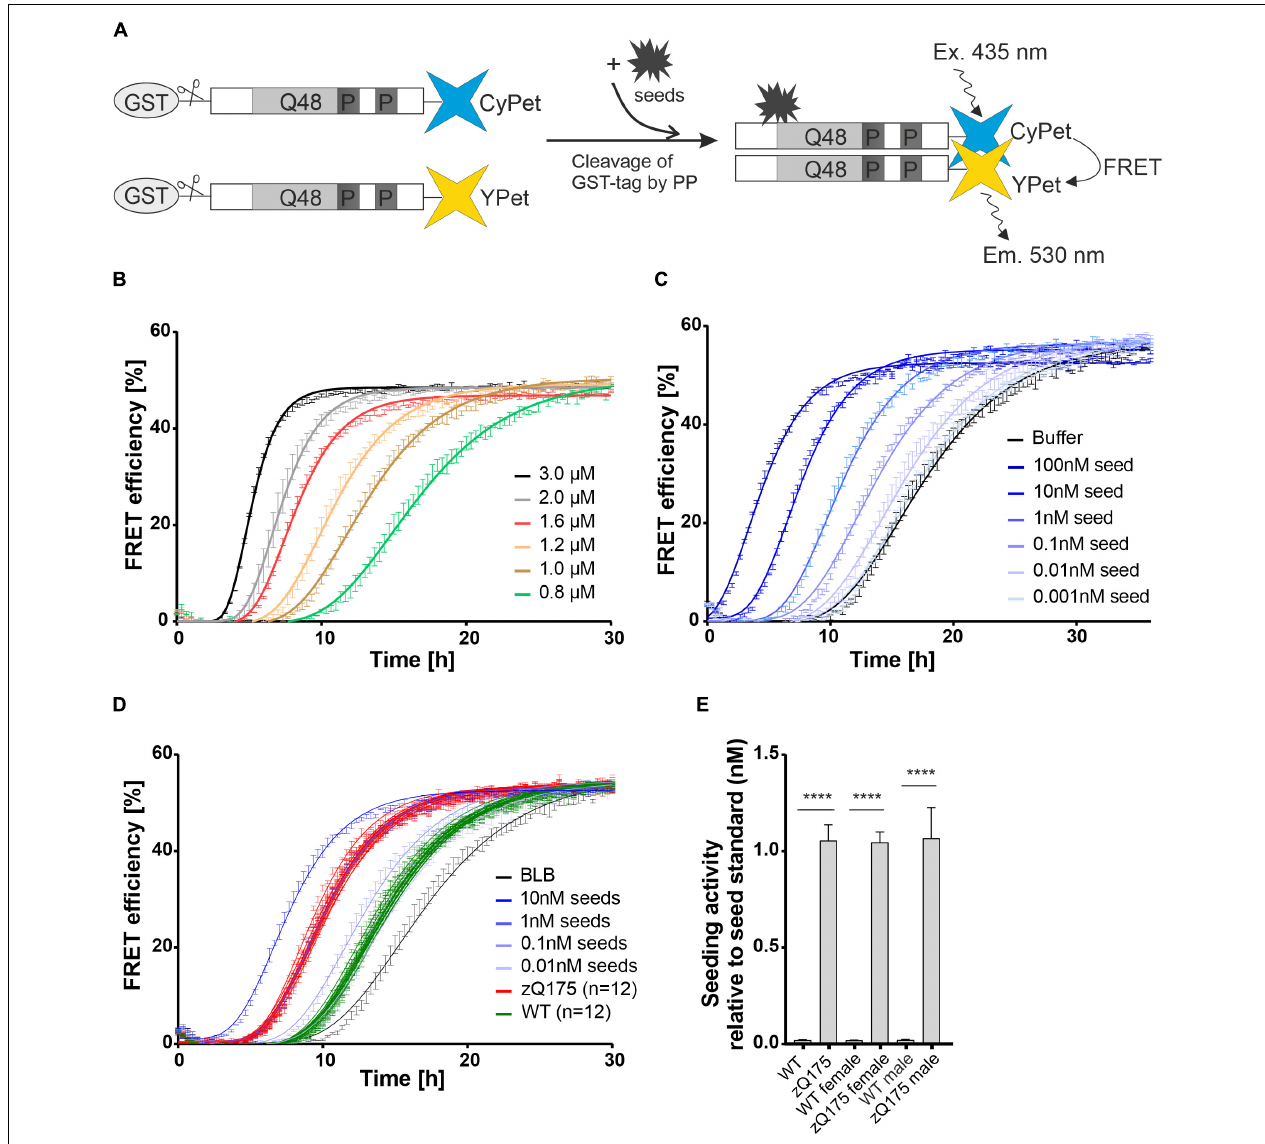
FIGURE 1 | Establishment of FRET-based mHTT aggregate seeding assay (FRASE) for testing biological samples. (A) Schematic representation of FRASE. PP, PreScission Protease. (B) Time- and concentration-dependent co-aggregation of Ex1Q48-CyPet and Ex1Q48-YPet sensor proteins (1:1 mixture, 0.8–3.0 µ M) monitored by repeated FRET measurements. FRET efficiency is displayed as mean ± SEM of technical triplicates. (C) Effect of different concentrations of preformed Ex1Q48 seeds on Ex1Q48-CyPet and Ex1Q48-YPet (1:1 mixture, 1.2 µ M) co-aggregation. Data are mean ± SEM of technical replicates. (D) FRASE analysis of crude brain extracts prepared from 6-month-old WT and zQ175 mice. Whole hemispheres were used for preparation. Different concentrations of preformed sonicated recombinant Ex1Q48 aggregates were used as seed standard. 4 µ g total mouse protein per replicate was applied. BLB, brain lysis buffer. Data are mean ± SEM of three technical replicates. Number of biological replicates is indicated. (E) Quantification of seeding activity in mouse brain extracts investigated in panel (D) . Seeding activities were normalized to the seed standard. The first bars (WT and zQ175 mice) represent all 12 biological replicates analyzed in panel (D) . Six of these mice were female and six were male. The following bars represent six biological replicates of female and male mice, respectively. Data are mean ± SEM of biological replicates. Statistical analysis: Unpaired t -test between WT and zQ175 mice (****, p value <